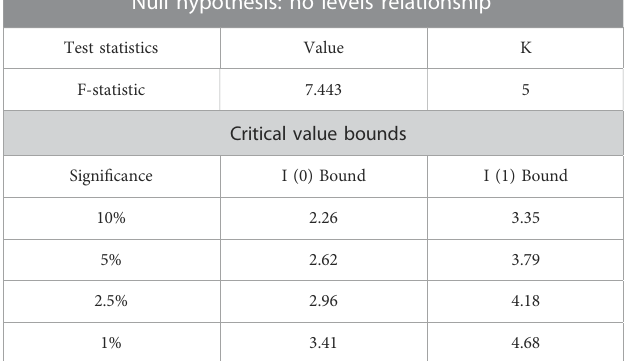
TABLE 4 F-bounds test.